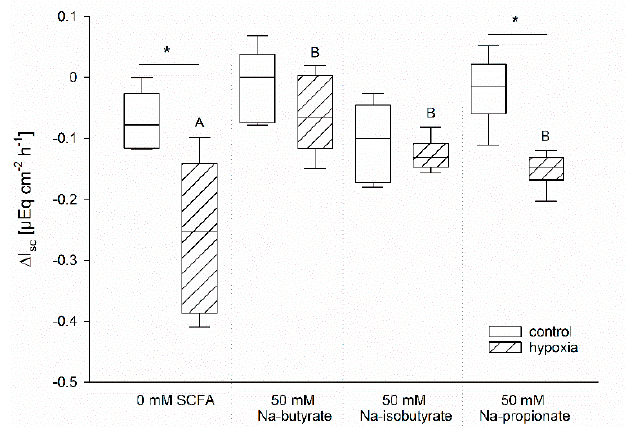
Figure 4. Drop in I sc after one hour of incubation under control (white bars) or hypoxic (hatched bars) conditions. The Δ I sc was calculated as the difference between the I sc immediately before the simulation of hypoxia and the values after 60 min of (hypoxic) incubation. Epithelia were incubated without any SCFA or with 50 mM Na-butyrate, Na-iso-butyrate, or Na-propionate. Only the SCFA-free and the Na-propionate incubation resulted in a significant difference between the control and the hypoxic group, as indicated by asterisks. Comparison within the gassing groups resulted in a significantly higher drop in I sc in the SCFA-free group compared to the others, as indicated by different letters. Boxes represent the median ± 10th, 25th, 75th and 90th percentile, N = 6 (n = 12), two-way ANOVA with subsequent Holm–-Sidak-multiple comparison, p < 0.05.